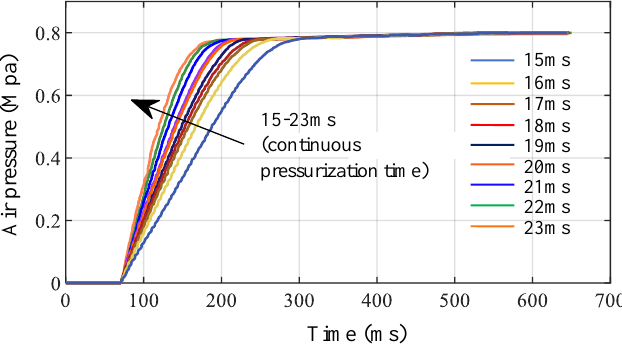
Figure 10. Relationship curve between the pressurization rate and pressurization duration.